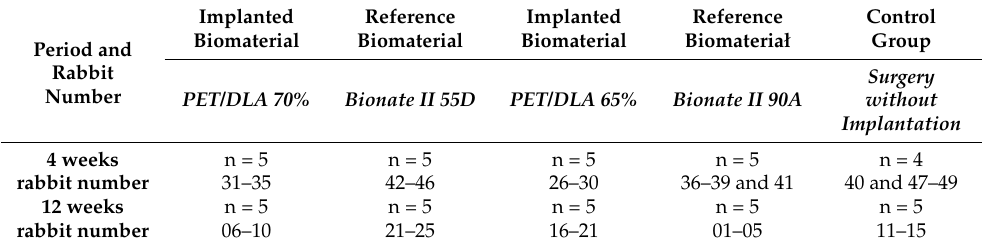
Table 1. Animal groups participating in the